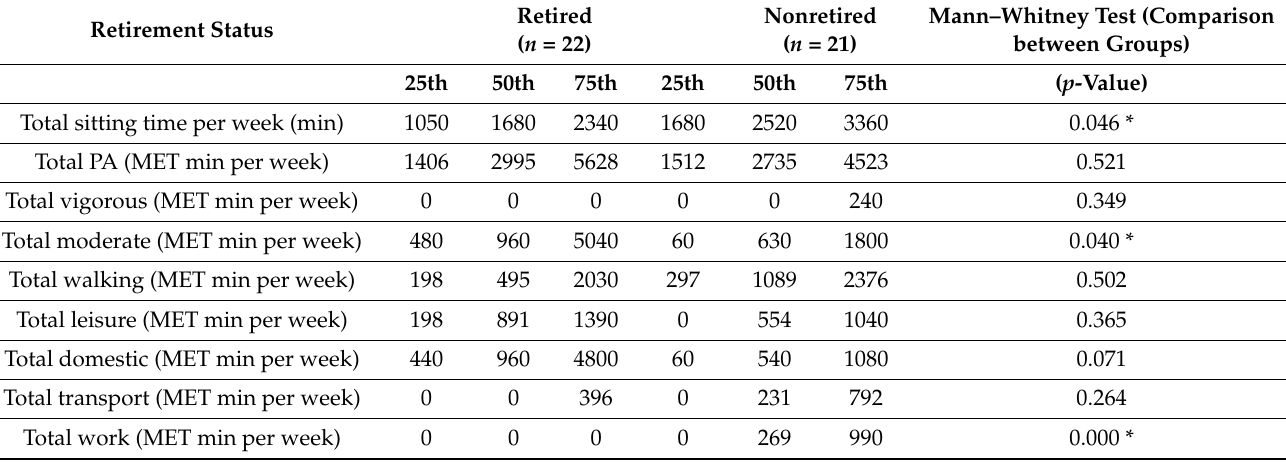
Table 2. Differences in PA and SB by retirement status.